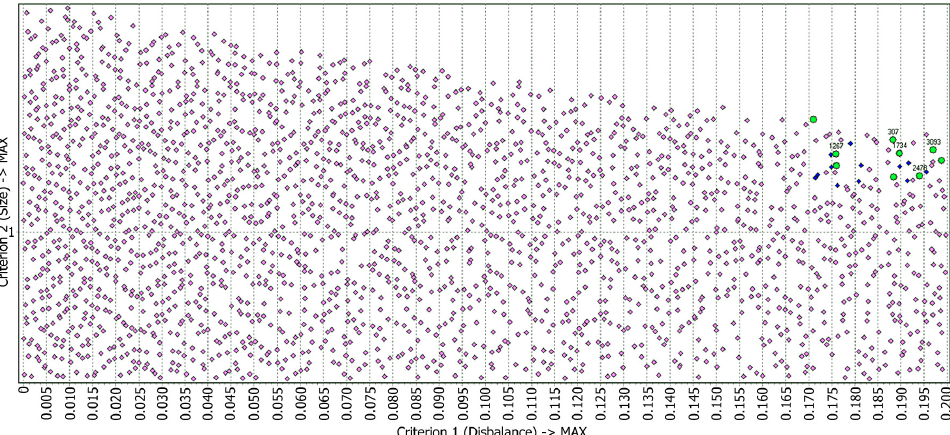
Figure 9. The set of solutions in the space of criteria: K 1 and K 2 . Selected solutions are numbered at the